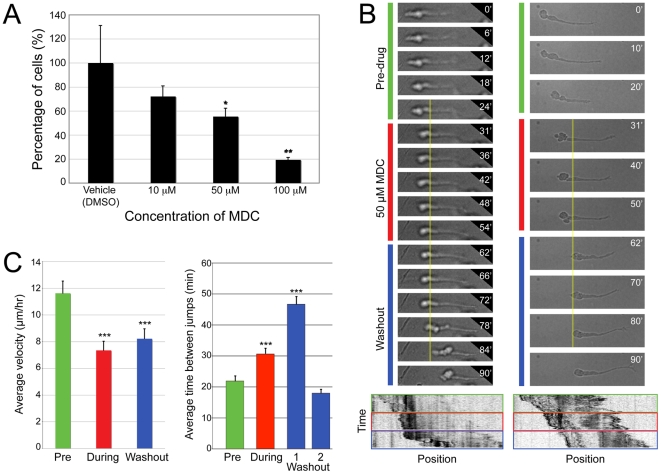
Inhibiting clathrin impairs SVZa neuron migration.(A) Fewer DAPI-stained nuclei are present outside explants at increasingly higher concentrations of MDC. (B) Time-lapse series of two neurons treated with MDC. The yellow line marks the position of the dilation at the time of MDC addition, which becomes that of the cell rear after washout. (Bottom) Kymographs plotting time vs. position highlight the positions of the cell rears. See Movies S4, S5. (C) Average velocity (µm/hr) of neurons migrating before the addition of MDC is significantly faster than that in the presence of the drug or after washout (n = 63). The amount of time a cell spends in the same position between translocations is significantly longer before the first translocation after washout (Washout-1, n = 66) compared to either before (Pre, n = 48) or in the presence of MDC (During, n = 40). Cells that made additional translocations during washout (Washout-2, n = 46) showed inter-translocation interval values similar to those before MDC addition. Data presented as mean ± SEM, *p<0.05, **p<0.01, ***p<0.001, Student's t-test.